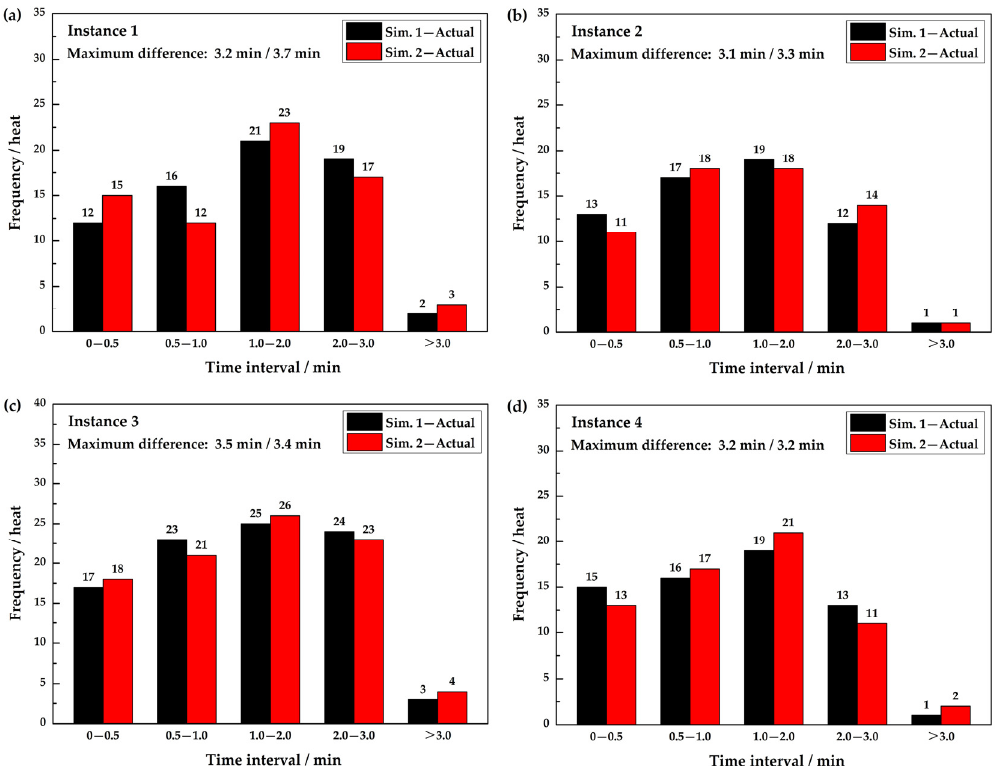
Figure 11. Distributions on the transfer times of heats from LF to CCM.